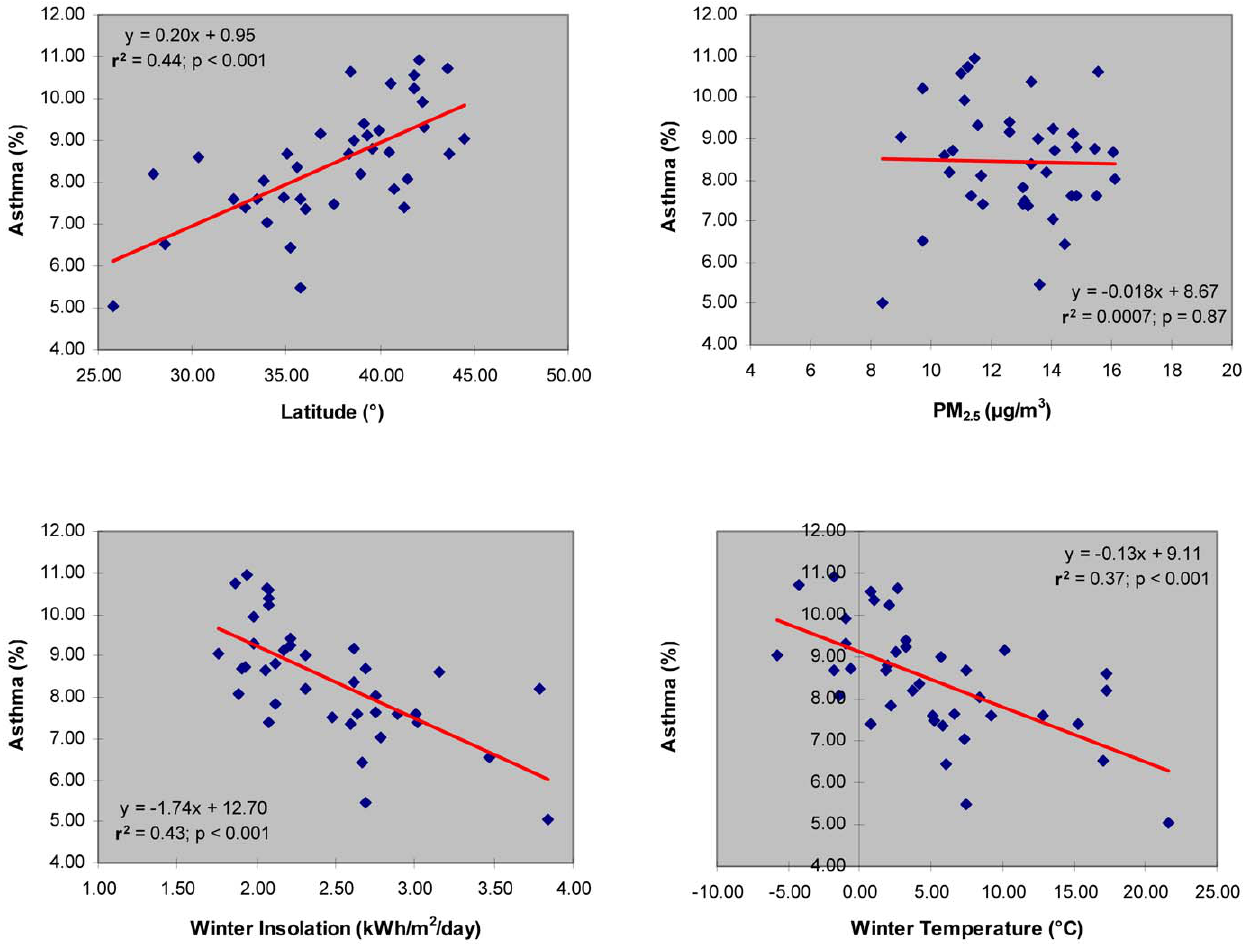
Figure 2. Asthma prevalence vs. latitude, air pollution (PM 2.5 ), winter insolation, and winter temperature in adult population of 39 major metropolitan/micropolitan areas of the eastern seaboard.